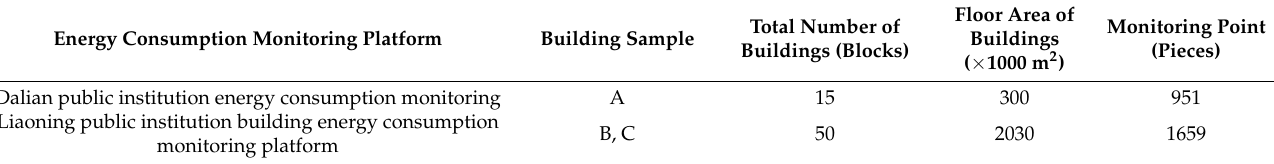
Figure 3. Daily maximum air temperature for three cities. Table 2. Basic information on building energy consumption monitoring